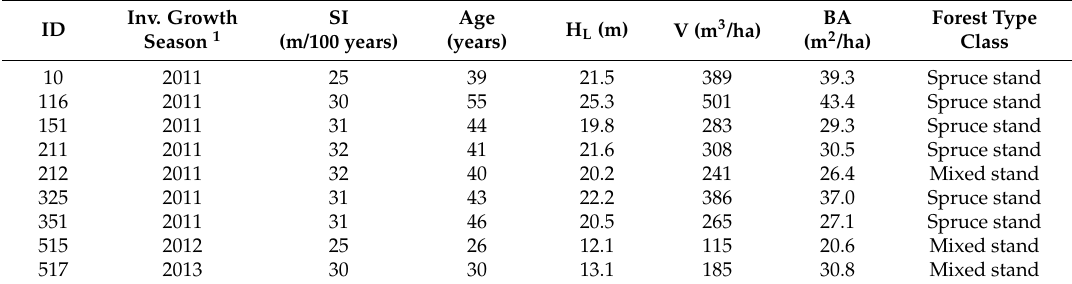
Table 2. Summary of the validation plots, i.e. , the nine large plots with 40 m radius that were used to validate the results of the data assimilation, at growth season 2011.